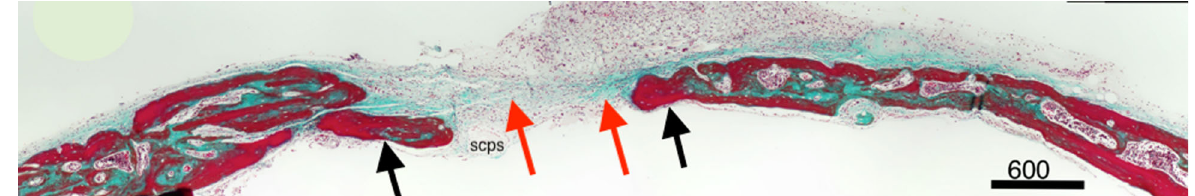
Fig. 12 Photomicrograph of Masson trichrome staining of the critical size bone defect grafted with DSM/SCPC/hBMSC showing new bone formation and maturation. Area of bone growth from the edge of the